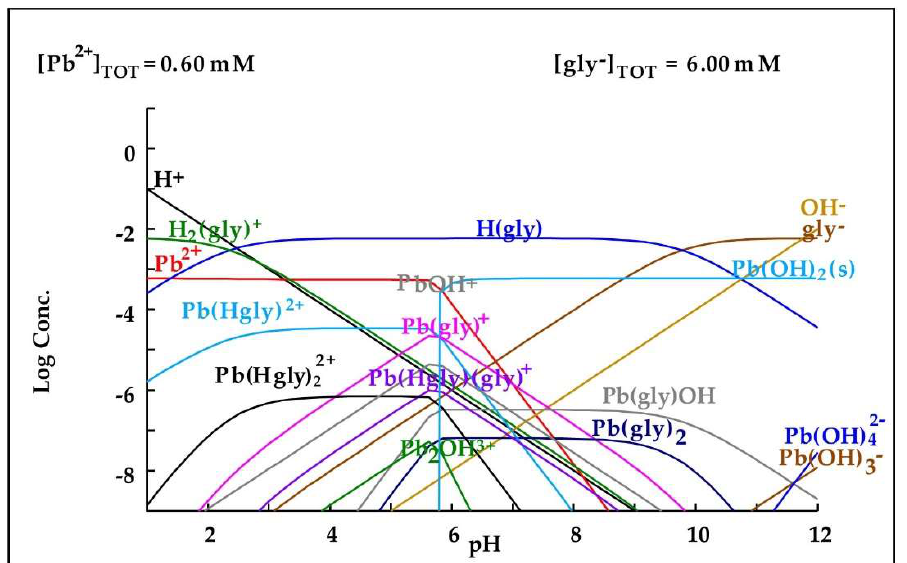
Figure 10. Diagram of distribution of species of the Pb 2+ -glycine − system based on the concentrations present in the leaching medium. Diagram made by the authors in Medusa software version 2010.